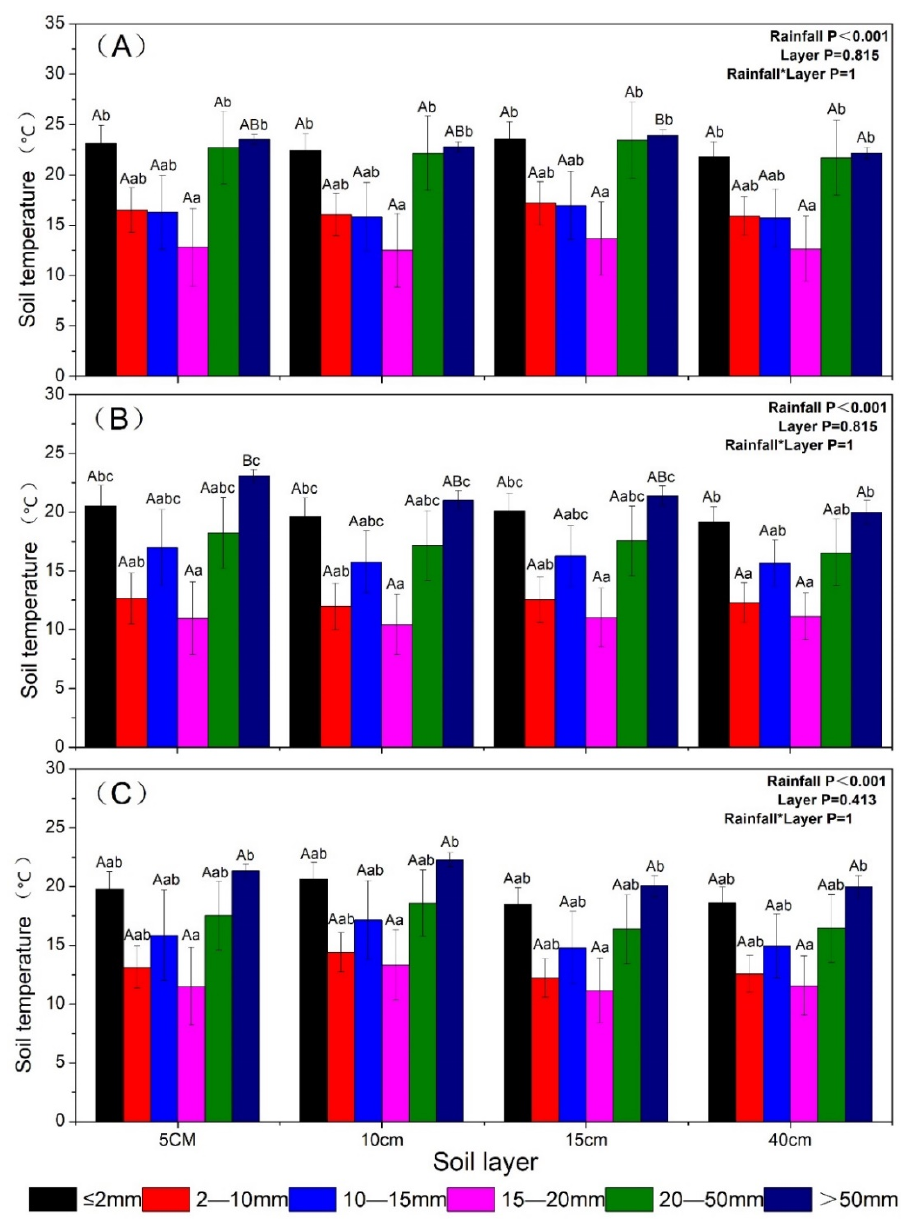
Figure 5. Soil temperatures in grassland, Q. acutissima , and C. lanceolata following different rainfall intensities. (Note: upper case letters indicate significant differences between different soil layers under the same rainfall intensities ( p < 0.05); lower case letters indicate significant differences between different rainfall intensities within the same soil layer ( p < 0.05); ( A ): grassland; ( B ): Q. acutissima ; ( C ): C. lanceolata ; land types: p < 0.001).